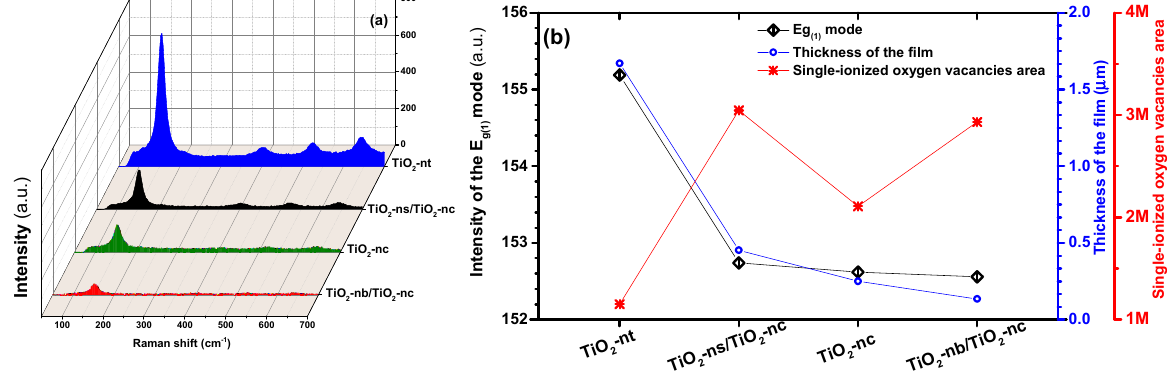
Figure 6. ( a ) Raman spectra of TiO 2 nanostructures; and ( b ) E g(1) mode displacement, thickness and oxygen vacancies for each nanostructure .